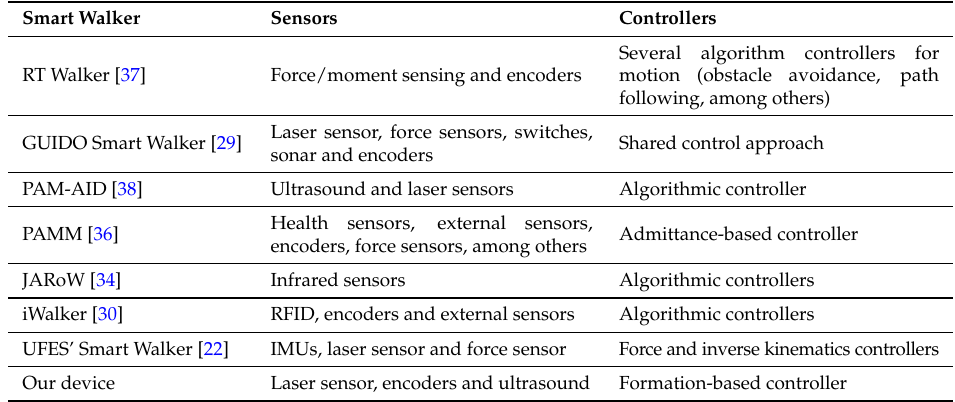
Table 1. Smart walkers’ controllers and